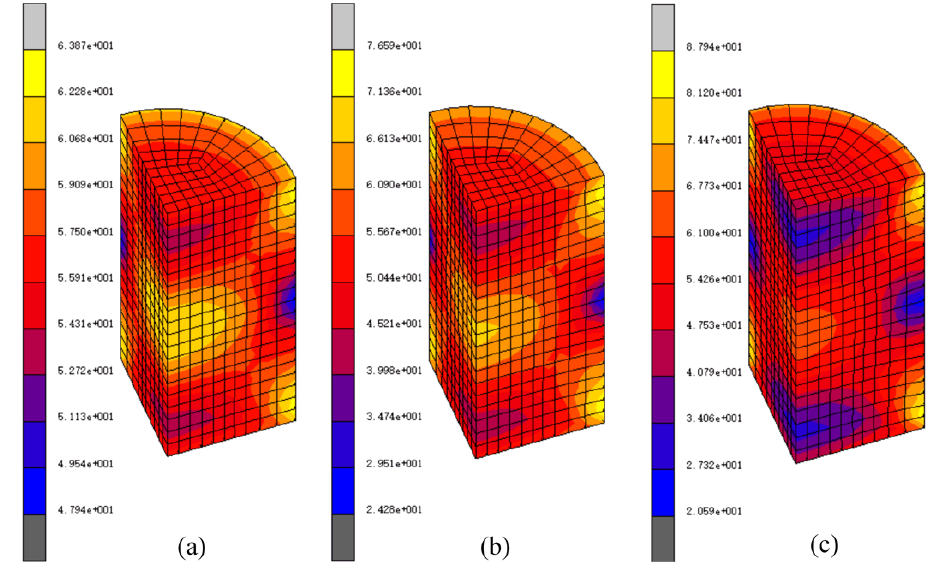
Figure 18. Equivalent von Mises stress distributions in powder compacts at different μ values of ( a ) 0.05, ( b ) 0.2, and ( c ) 0.4.